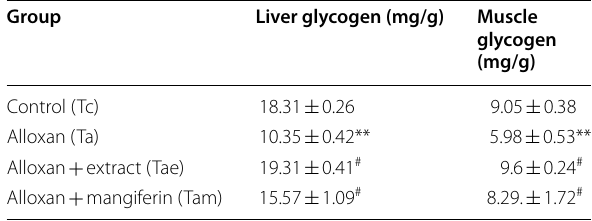
Table 3 Effect of mango peel extract and mangiferin on Liver and Muscle glycogen level in the alloxan-induced type I diabetic